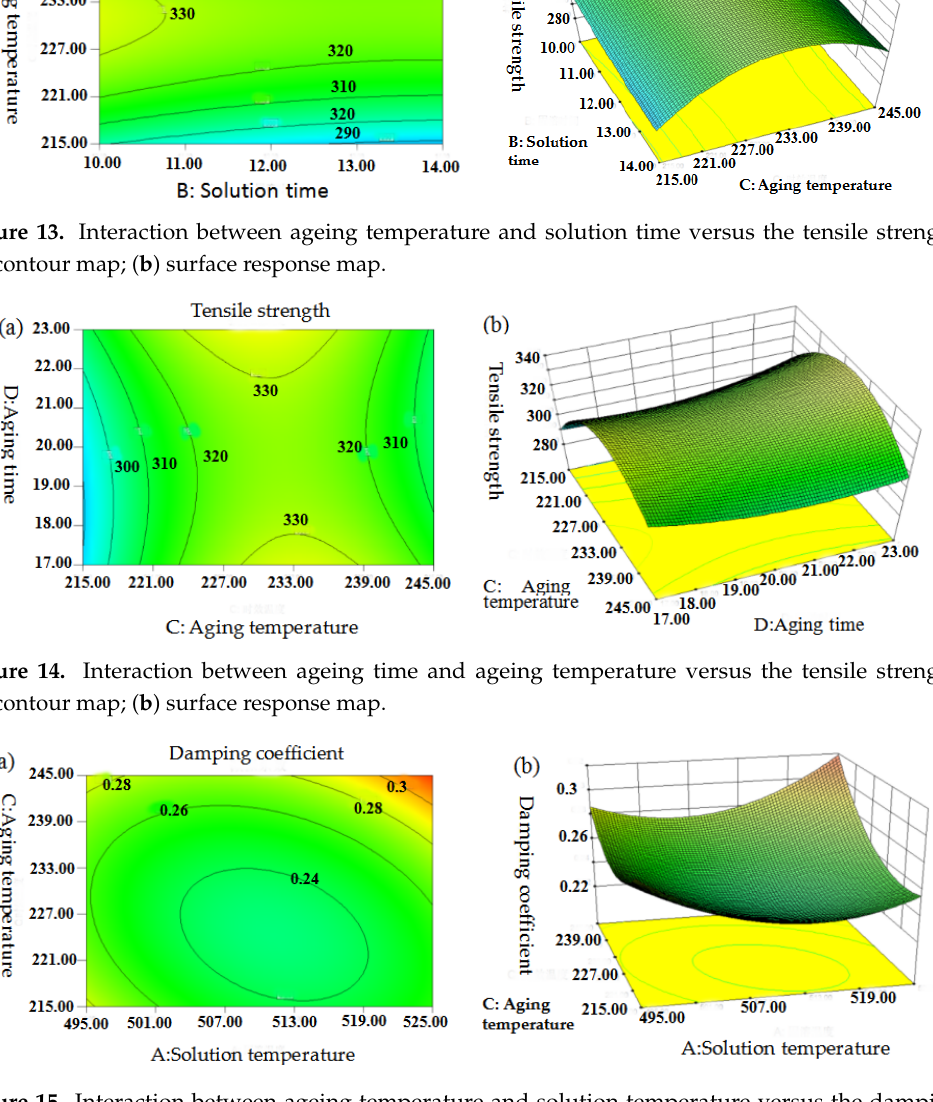
Figure 16. Interaction between ageing temperature and solution time versus the damping coefficient. ( a ) contour map; ( b ) surface response map.